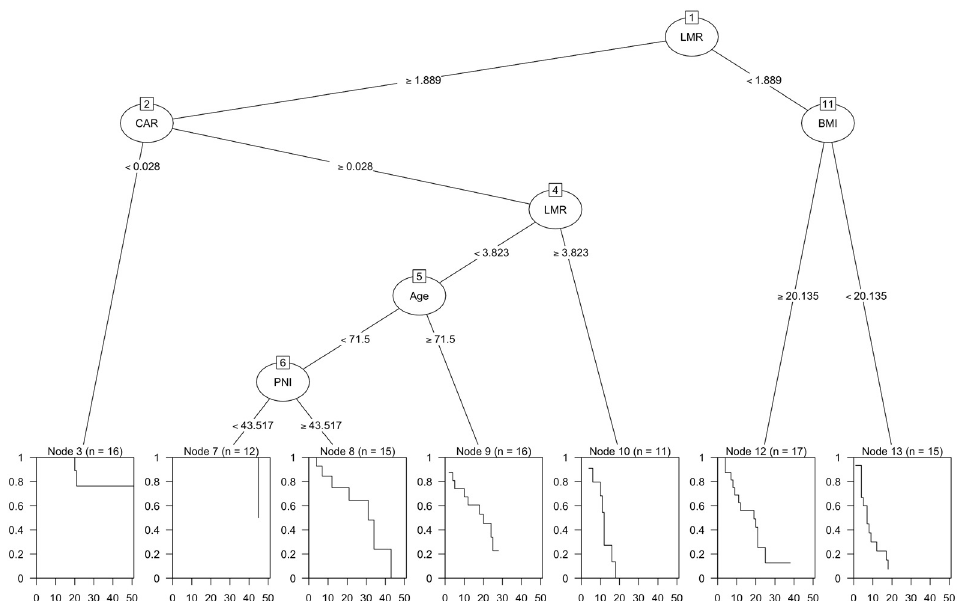
Figure 3. Classification and regression tree (CART) analysis. The root node was first divided based on LMR. For a high LMR, an interaction was found between CAR, age, PNI, and overall survival. For a low LMR, an interaction was found for BMI.